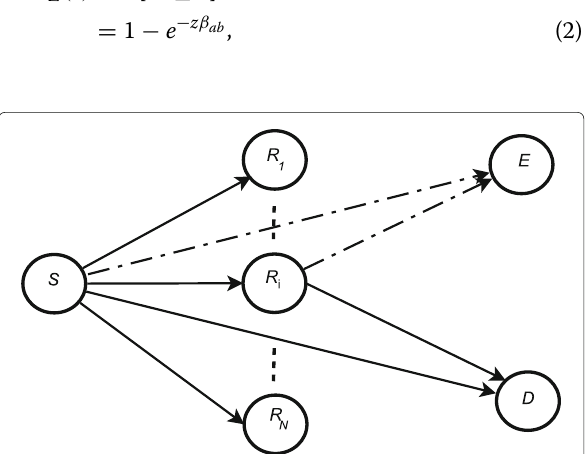
Fig. 1 Dual-hop cooperative threshold-based multi-relay